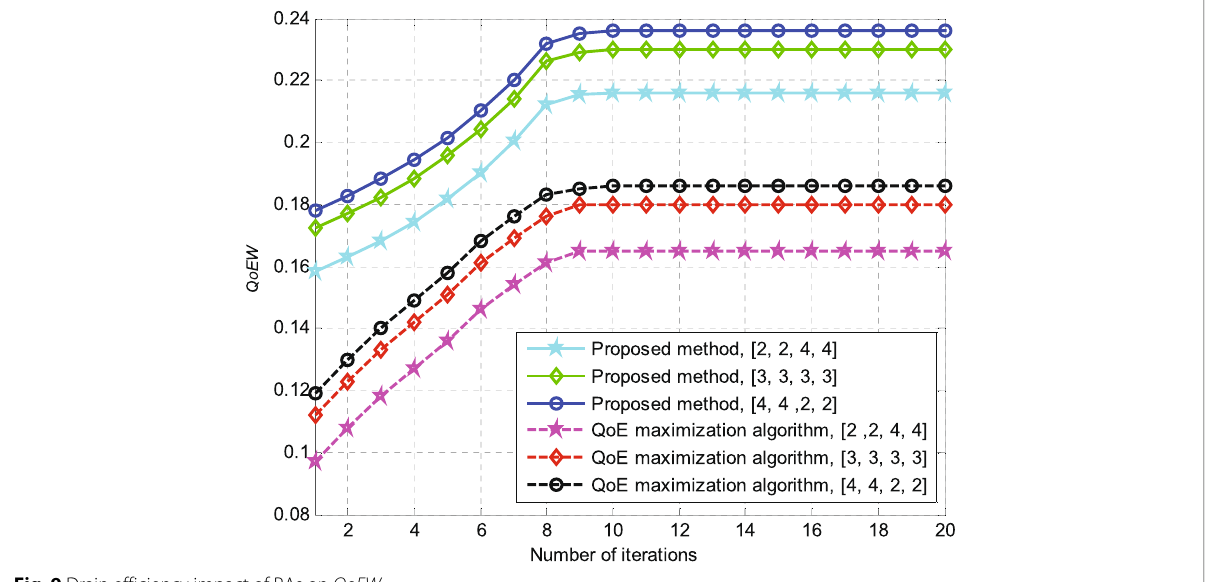
Fig. 9 Drain efficiency impact of PAs on